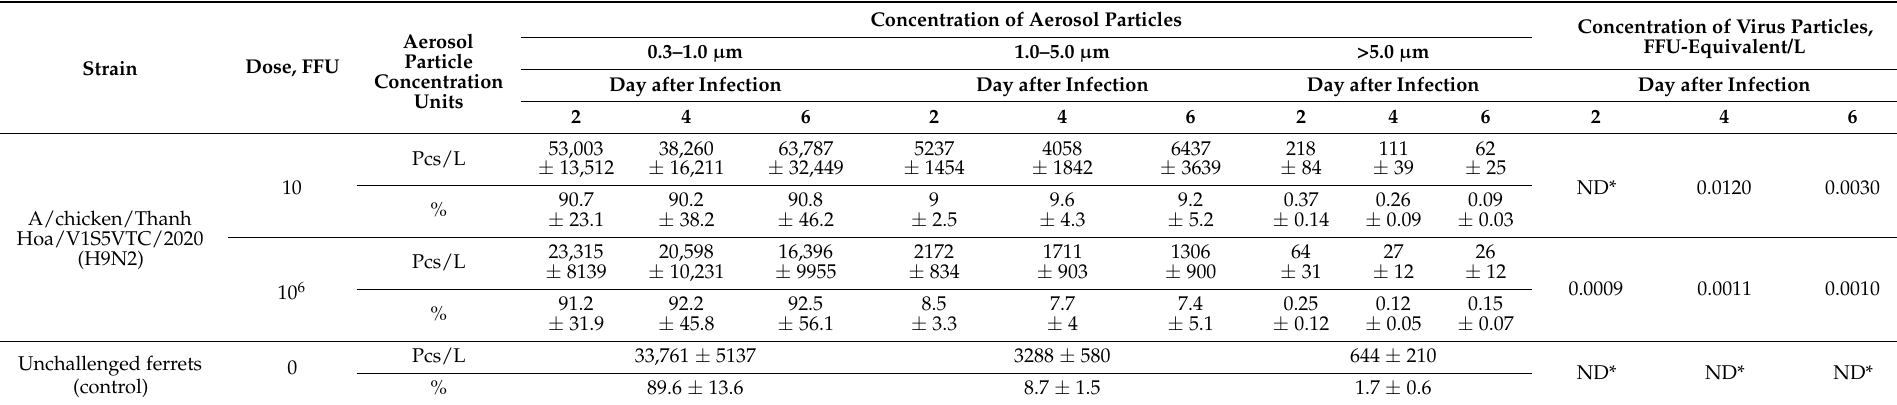
Table 2. Fractional composition of aerosol particles and airborne viral load (FFU-equivalent) in the air of aerobiology chamber at various time periods after